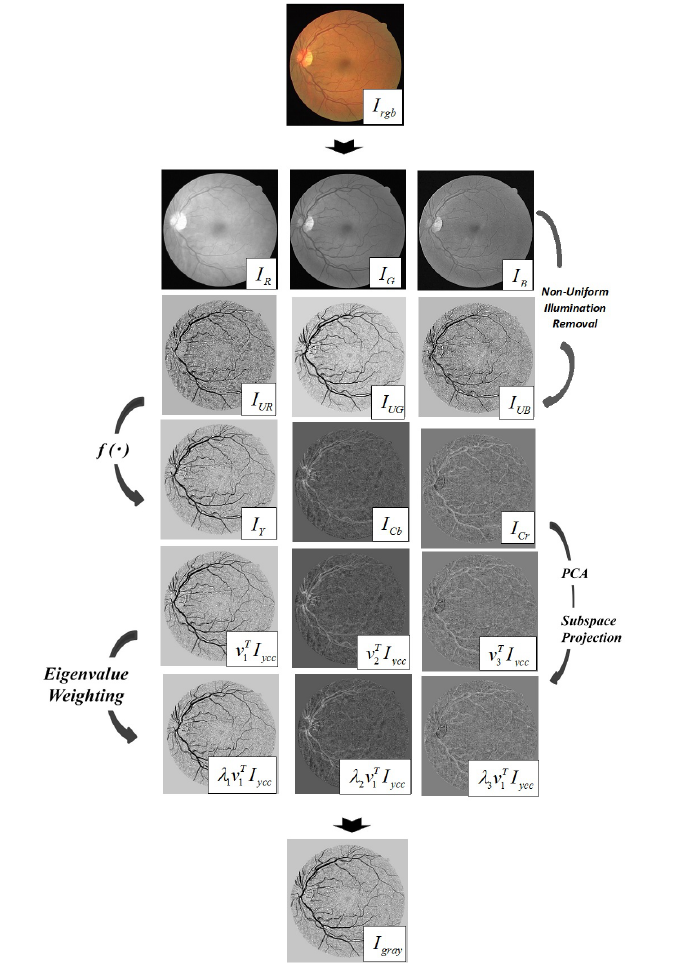
Figure 7. Our Proposed Model.